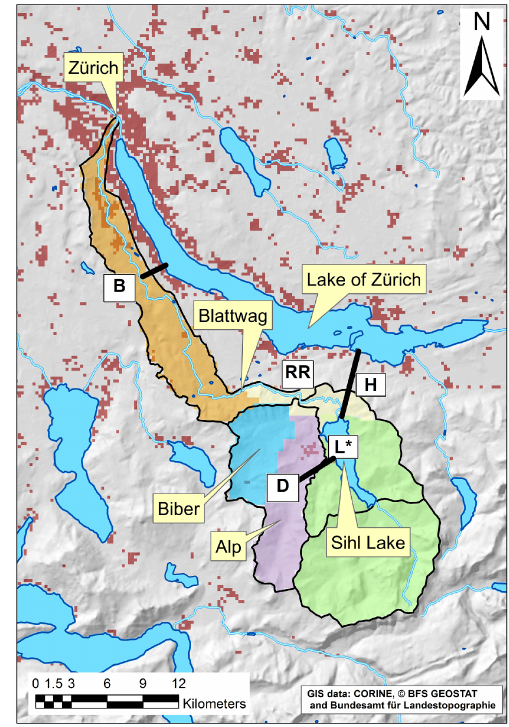
Figure 1. Overview map of the Sihl river and its sub-catchments. The white lables visualize the major flood management options. See further details in the text and in Fig. 3. Red areas represent built-up regions. GIS elements reproduced by kind authorization of “swis- stopo” (JA022265), BFS GEOSTAT/BUWAL.